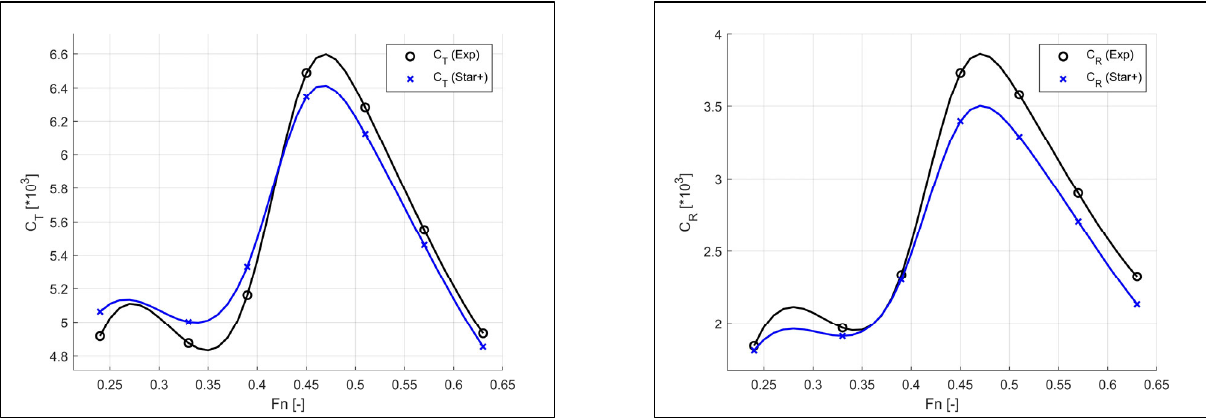
Figure 6. Numerical total ( left ) and residual ( right ) resistance values compared to the experiments.